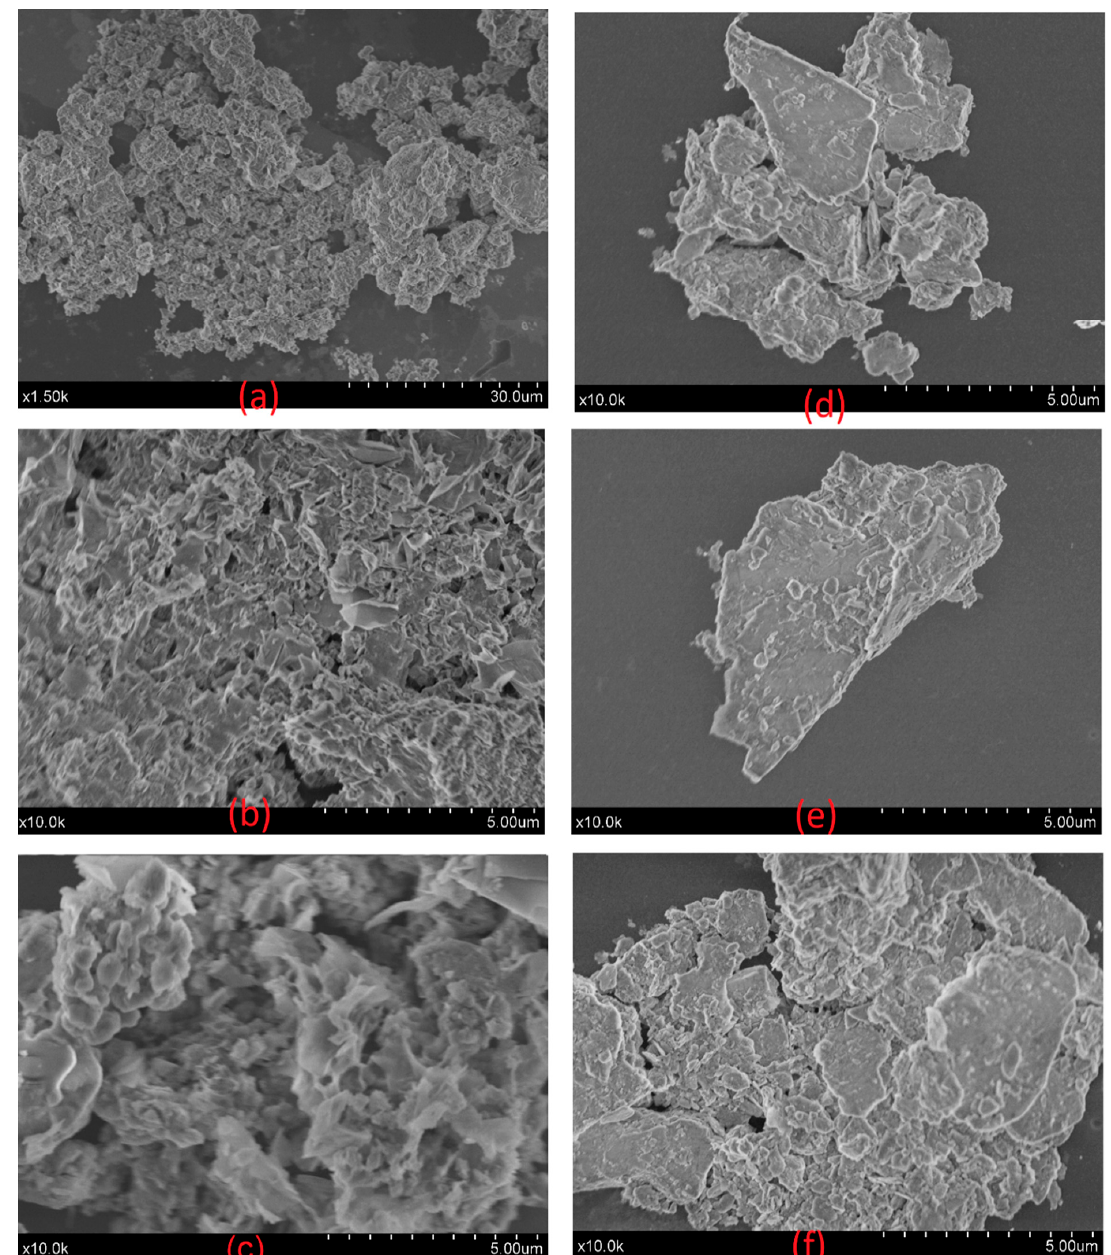
Figure 8. SEM micrographs (different magnifications) of OPBS ( a – c ) and soils ( d – f ).